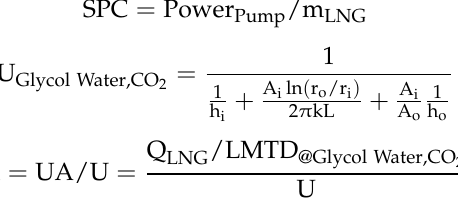
Table 3. System operating compositions.